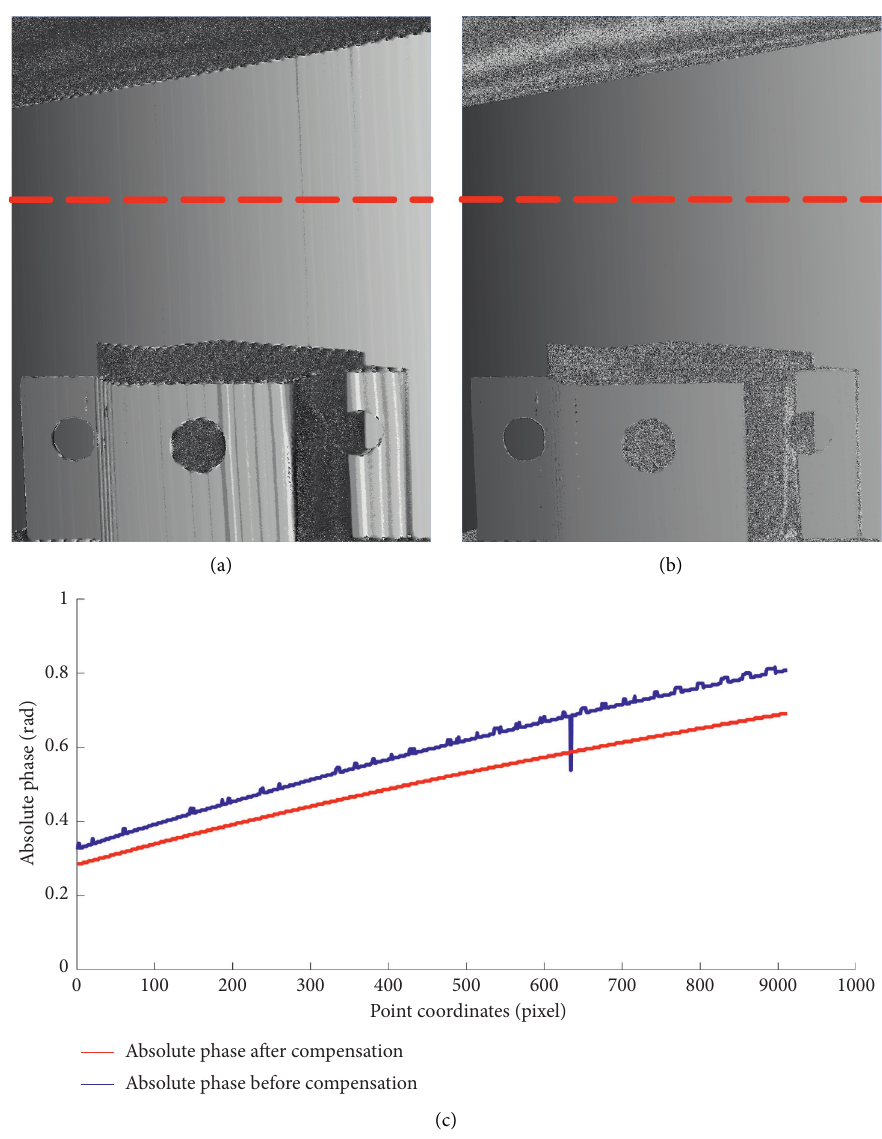
Figure 11: Comparison of absolute phase error compensation. (a) Three-frequency with four-phase shifts’ method; (b) our proposed method; (c) comparison of absolute phase measurement errors in 400 lines. Table 2: RMS before and after correction of compensation by the proposed method. Fringe